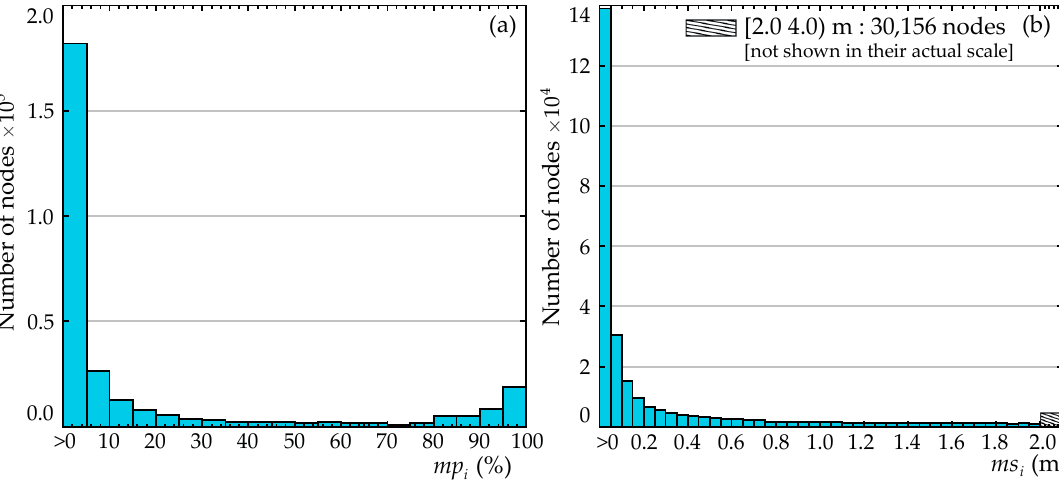
Figure 8. Histograms of the problematic nodes for ( a ) the percentage of misinformation and ( b ) the maximum surge misinformation.